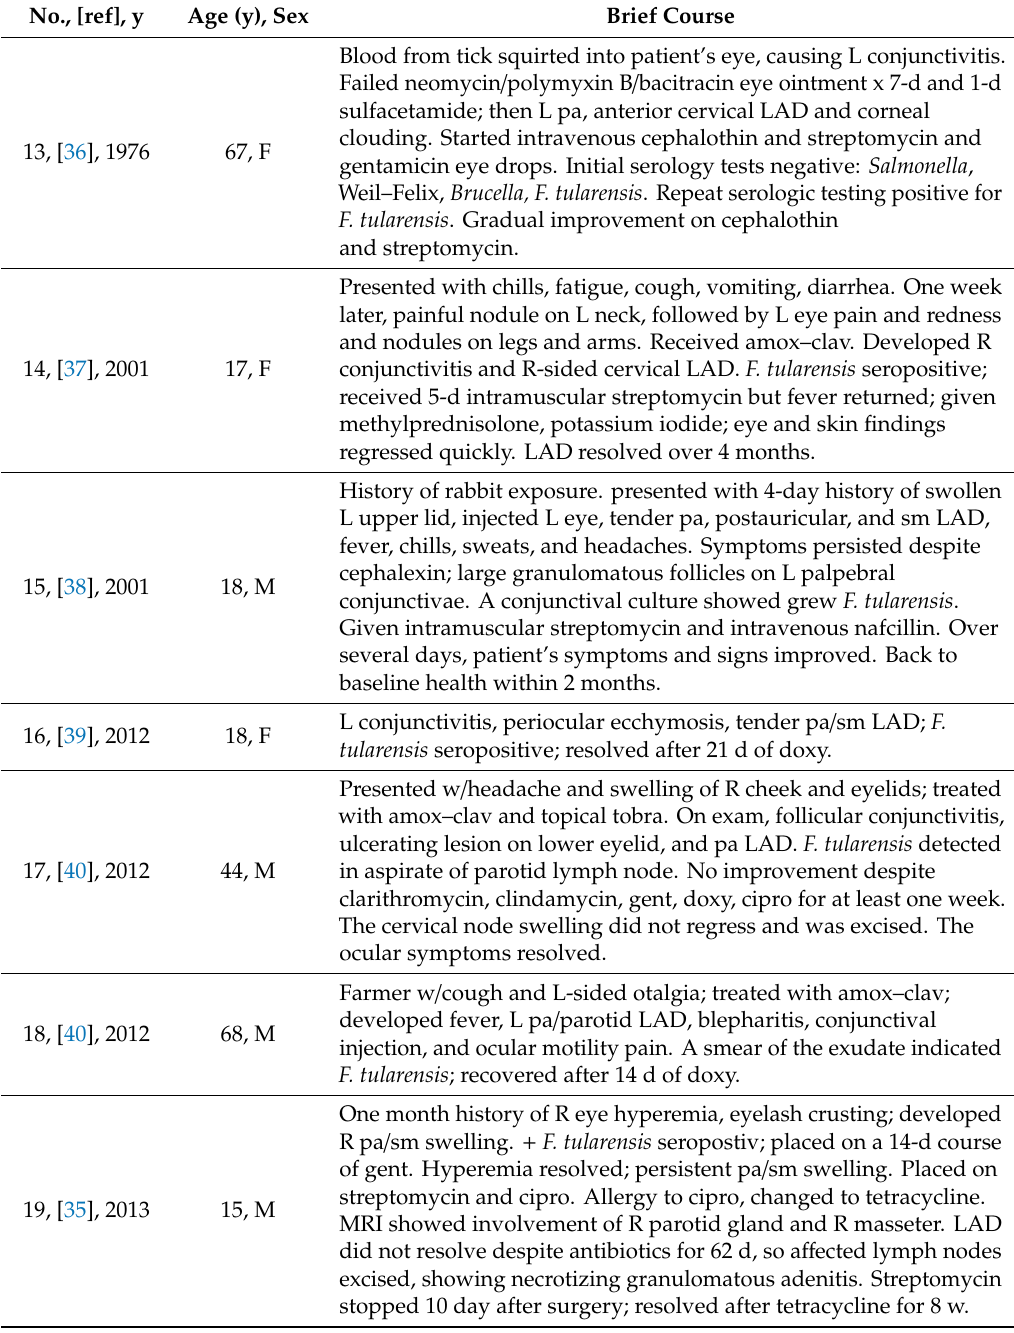
Table 3. Cases of oculoglandular